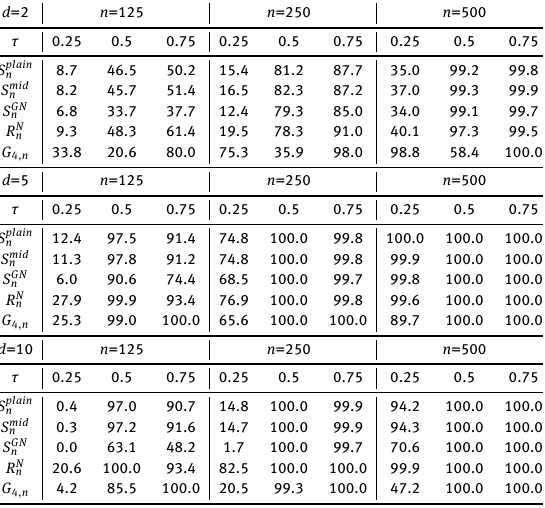
Table 6: Percentages of rejection at 5% significance level, as estimated from 1000 replicates, for the tests based on S plain n , S mid n , S GN n , R N n and G 4, n under the Squared Pearson Type II copula (*Kendall’ τ refers to the associated Pearson Type II